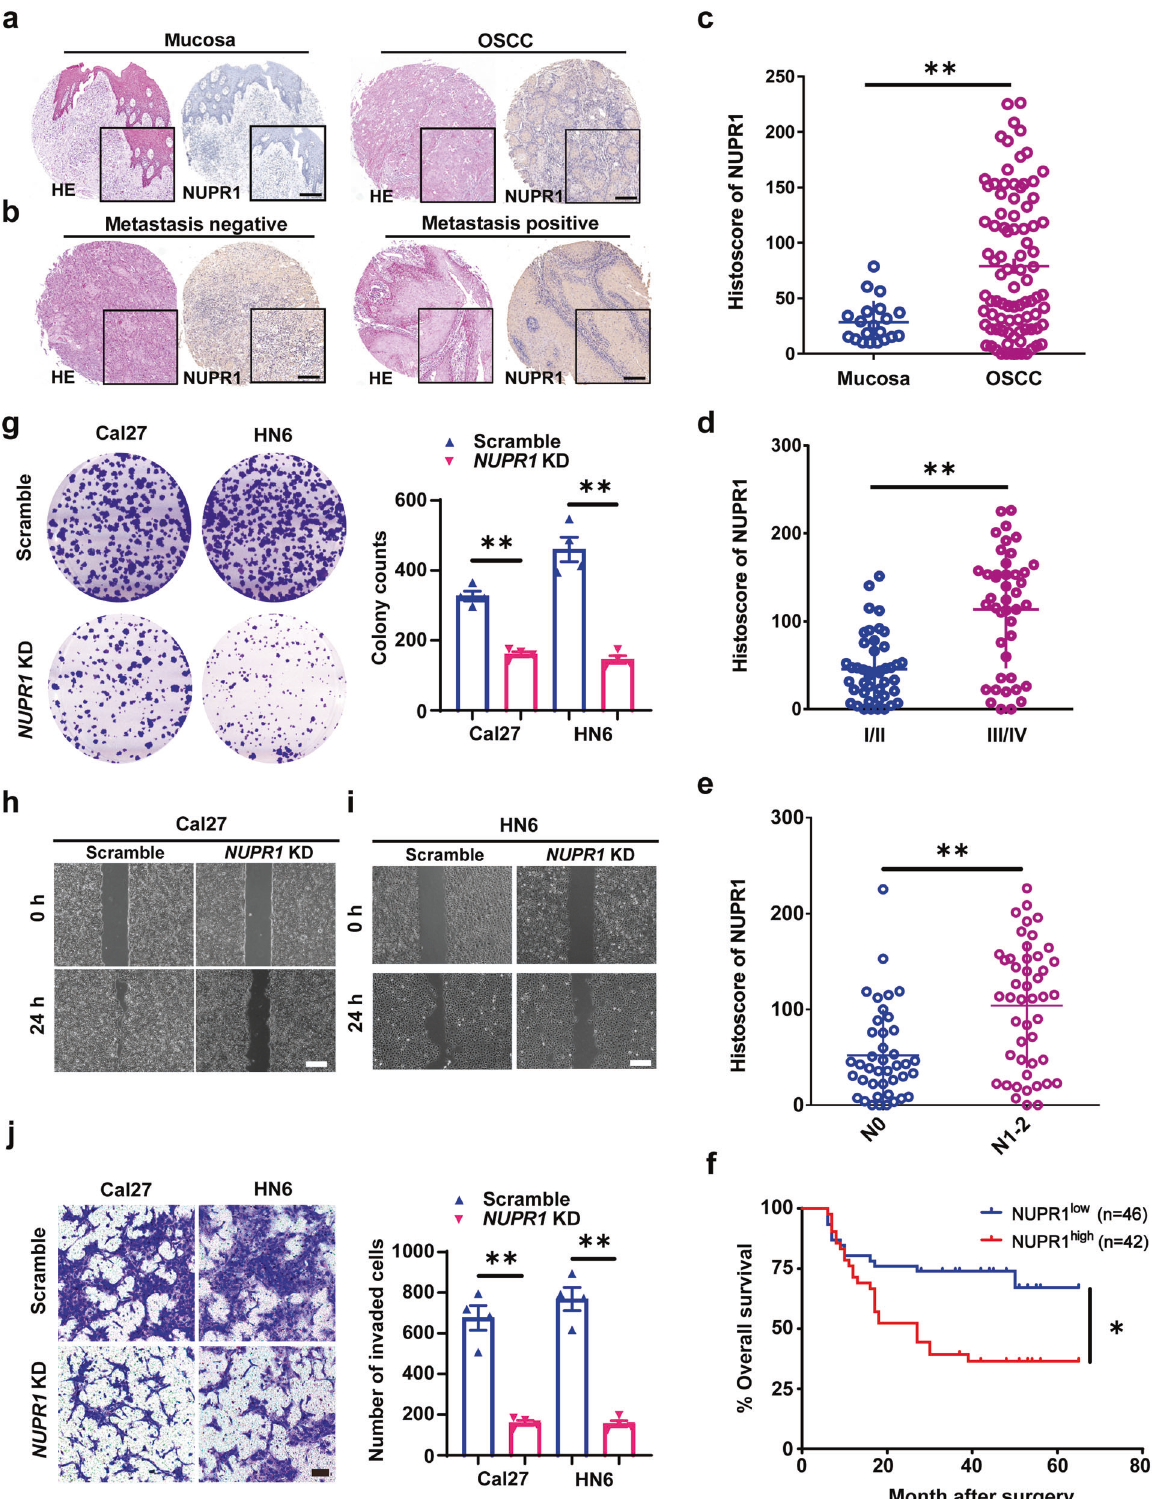
indicating that NUPR1 KD does not affect phagophore formation (Supplementary Fig. S4c, d). Polyubiquitinated protein aggregates, whose formation is mediated by SQSTM1, a cargo incorporation of autophagosomes, are crucial components of mature autophago- somes. 24 We evaluated autophagosome maturation by